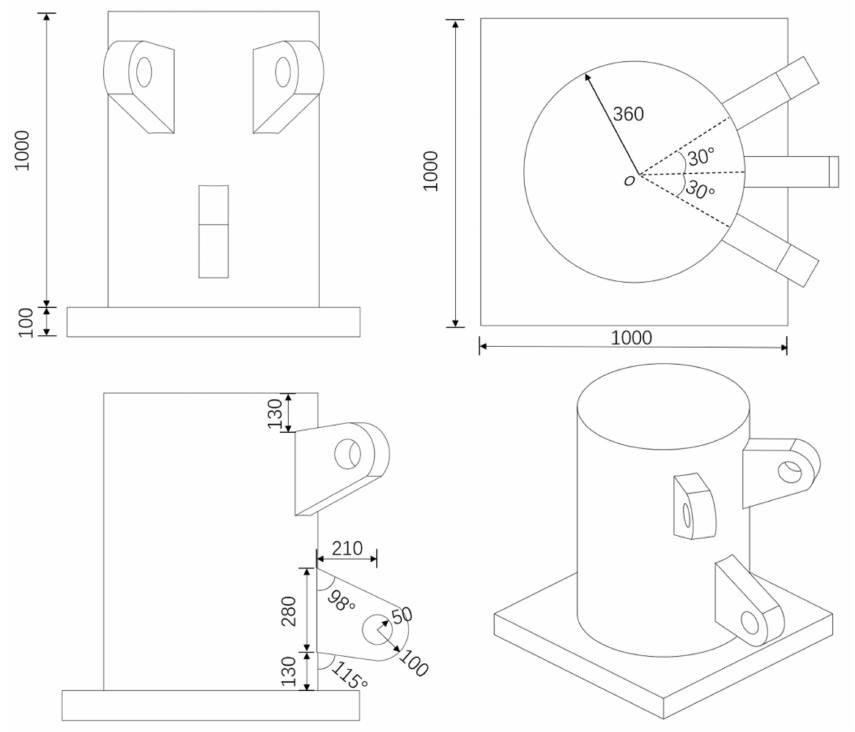
Figure 4. Geometry size of support (unit: